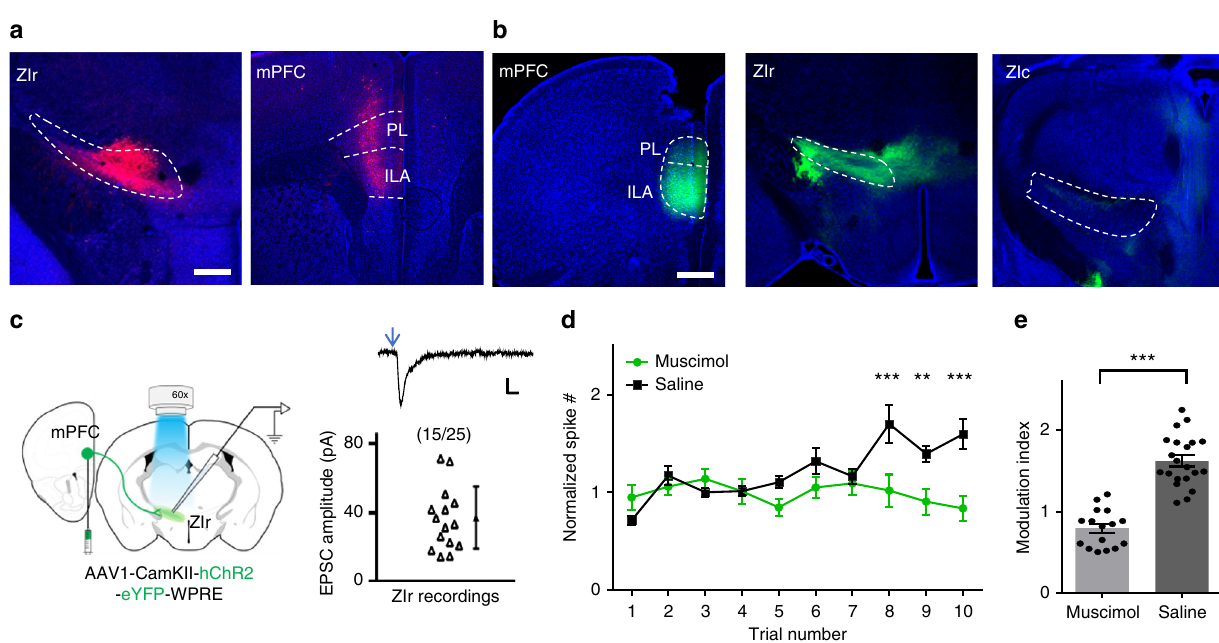
Fig. 6 mPFC contributes to ZIr activity increase during extinction. a Injection of rAAV2-retro-syn-Cre into ZIr of Ai14 mouse. Left, tdTomato expression around the injection site. Right, retrogradely labeled presynaptic neurons (red) in mPFC. Blue shows Nissl staining. ILA and PL subregions are marked. Scale: 500 µ m. b Injection of GFP virus into mPFC of wild-type mice. Left, GFP expression at the injection site. Middle, GFP-labeled axons in ZIr. Right, no GFP-labeled axons in the more caudal part of ZI. Scale: 500 µ m. c Left, experimental paradigm. Right, average EPSC amplitudes of 15 out of 25 recorded ZIr neurons in response to LED activation of mPFC axons. Recording was made in the presence of TTX and 4-AP. Top inset, average EPSC trace for an example ZIr neuron. Arrow points to the onset of LED. Scale: 40 pA, 10 ms. d Average normalized spike rate of ZIr units during extinction training for saline control (black, n = 21 units from seven animals) and mPFC muscimol injected (green, n = 16 units from six animals) mice. *** p (trial 8) < 0.001, ** p (trial9) = 0.002, *** p (trial10) < 0.001, two-sided Mann – Whitney U test. e Modulation index calculated for each unit in the saline and muscimol group. *** p < 0.001, two- sided unpaired t -test. Solid symbol represents mean ± s.e.m. for all